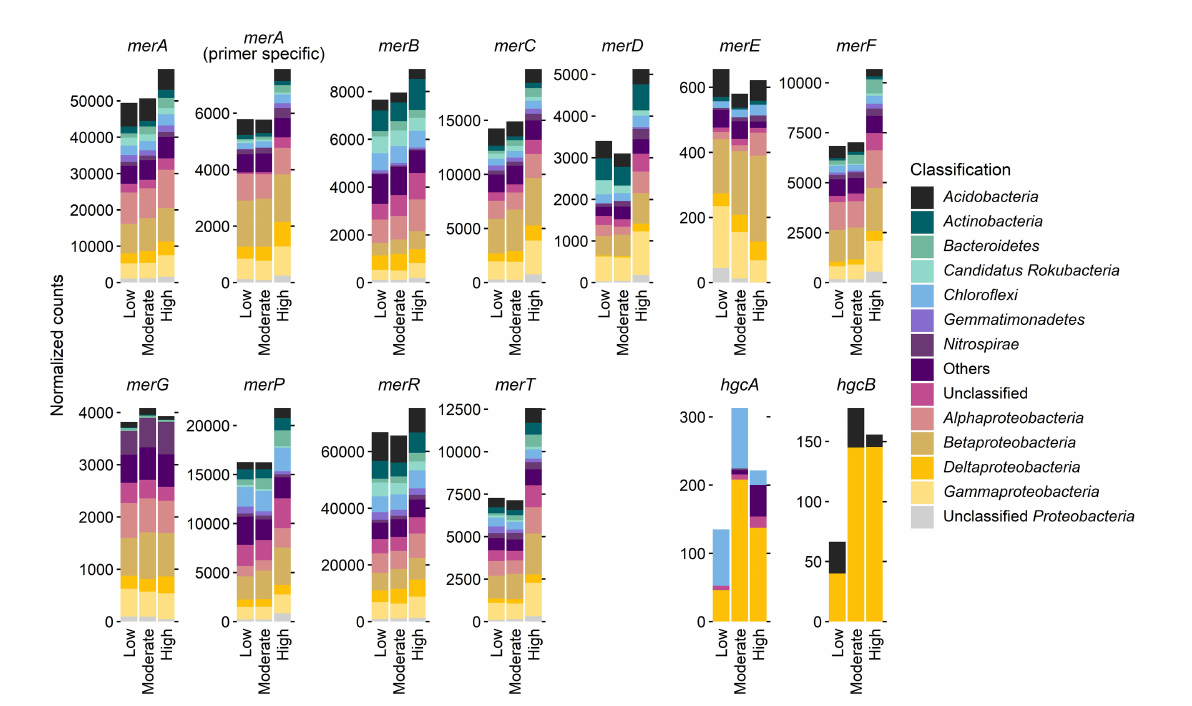
FIGURE3 Normalized counts of mer and hgc genes at the three sites with different Hg contamination levels (low, moderate, high), and itemized according to the most dominant bacterial phyla or subphyla. Whereas Alpha -, Beta -, and Gammaproteobacteria belong to the phylum Proteobacteria , Deltaproteobacteria now belong to the novel phylum-level lineage Thermodesulfobacteriota and Myxococcota (Oren and Garrity, 2021).